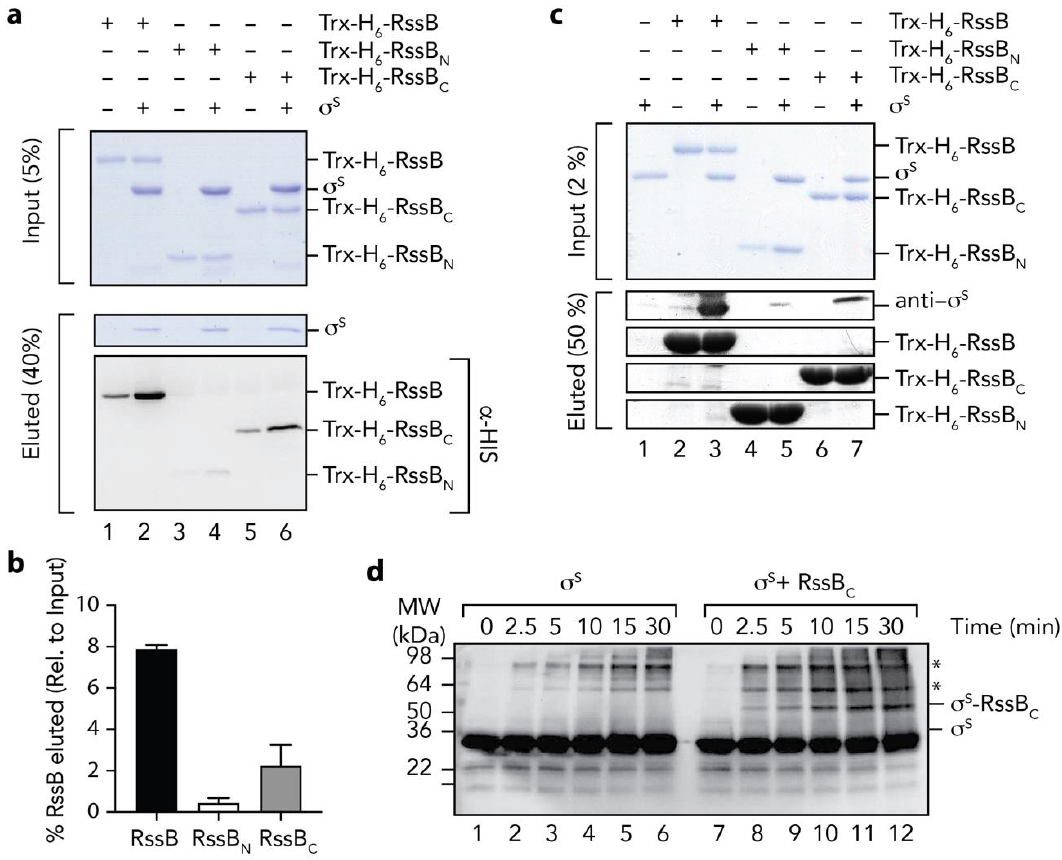
Figure 5. The C-terminal domain of RssB is sufficient for interaction with σ s . ( a ) RssB (lanes 1 and 2), RssB N (lanes 3 and 4), or RssB C (lanes 5 and 6) were incubated in the absence (lanes 1, 3, and 5) or presence (lanes 2, 4 and 6) of σ s . RssB (wild type or individual domains) were co-immunoprecipitated using anti- σ s antisera. Proteins were separated by 15% SDS-PAGE and visualized by either staining with Coomassie Brilliant Blue or transfer to PVDF membrane and immunodecoration with anti-His (to visualize Trx-H 6 -RssB). The input (5%) is shown in the upper panel and the eluted proteins (40%) are shown in the lower panels. ( b ) Quantitation of in vitro σ s co-IP experiments show the binding of σ s to Trx-H 6 -RssB N (white bar) and Trx-H 6 -RssB C (grey bar), relative to wild type Trx-H 6 -RssB (black bar). Error bars represent S.E.M. of at least three independent experiments (n > 3). ( c ) In vitro σ s “pull-down” experiment illustrating the interaction of σ s (lane 1) with wild type Trx-H 6 -RssB (lanes 2 and 3), Trx-RssB N (lanes 4 and 5) and Trx-RssB C (lanes 6 and 7), in the presence (lanes 3, 5 and 7) or absence (lanes 2, 4, and 6) of σ s . Proteins were separated by 15% SDS-PAGE and visualized by staining with Coomassie Brilliant Blue or immunodecoration using anti- σ s antisera. The input (2%) is shown in the upper panel and the eluted proteins (50%) are shown in the lower panels. ( d ) Chemical crosslinking of σ s (using 0.005% ( v / v ) GA) was monitored in the absence (lanes 1–6) or presence (lanes 7–12) of RssB C . Following crosslinking, proteins were separated by SDS-PAGE, transferred to PVDF membrane and probed with anti- σ s antisera. * represents non-specific σ s crosslink products.